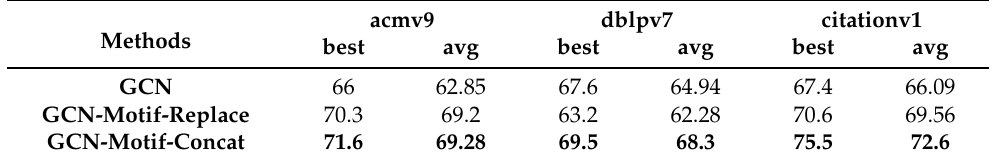
Figure 6. Performance comparison before and after integrating our proposed motif-based subgraph aggregation strategy. “GCN” and “GCNII” are two classic GNN models, respectively. “GCN-Motif” and “GCNII-Motif”, respectively, represent the improved model based on the subgraph aggregation and encoding strategy proposed in this paper. The horizontal axis of ( b ) represents the random edge rate. ( a ) Node classification on the full dataset; ( b ) node classification on incomplete Acmv9. Table 9. Performance of GCN when integrating different variants of our proposed motif-based subgraph aggregation strategy. “best” and “avg” represent the optimal and average performance over 20 experiments, respectively. Bold numbers represent the best results on different